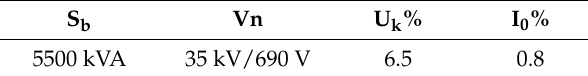
Table A3. Transformer parameters.